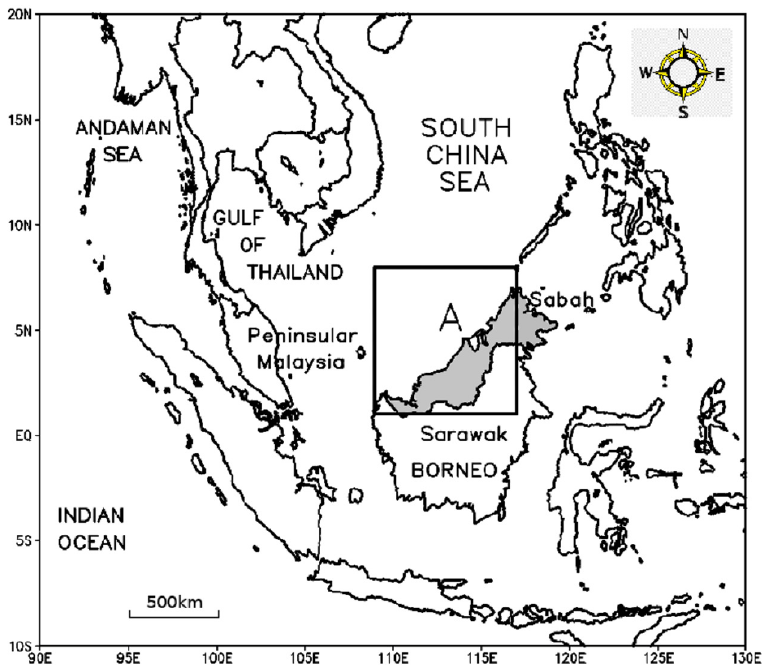
Figure 1. Topography map of the study area. Box A indicates the region where the events are selected, bounded from 1.0–8.0 ◦ N, 109.0–117.0 ◦ E. It covers the events that propagate towards Sarawak and Sabah coastlines. Sarawak and Sabah are shaded in grey.